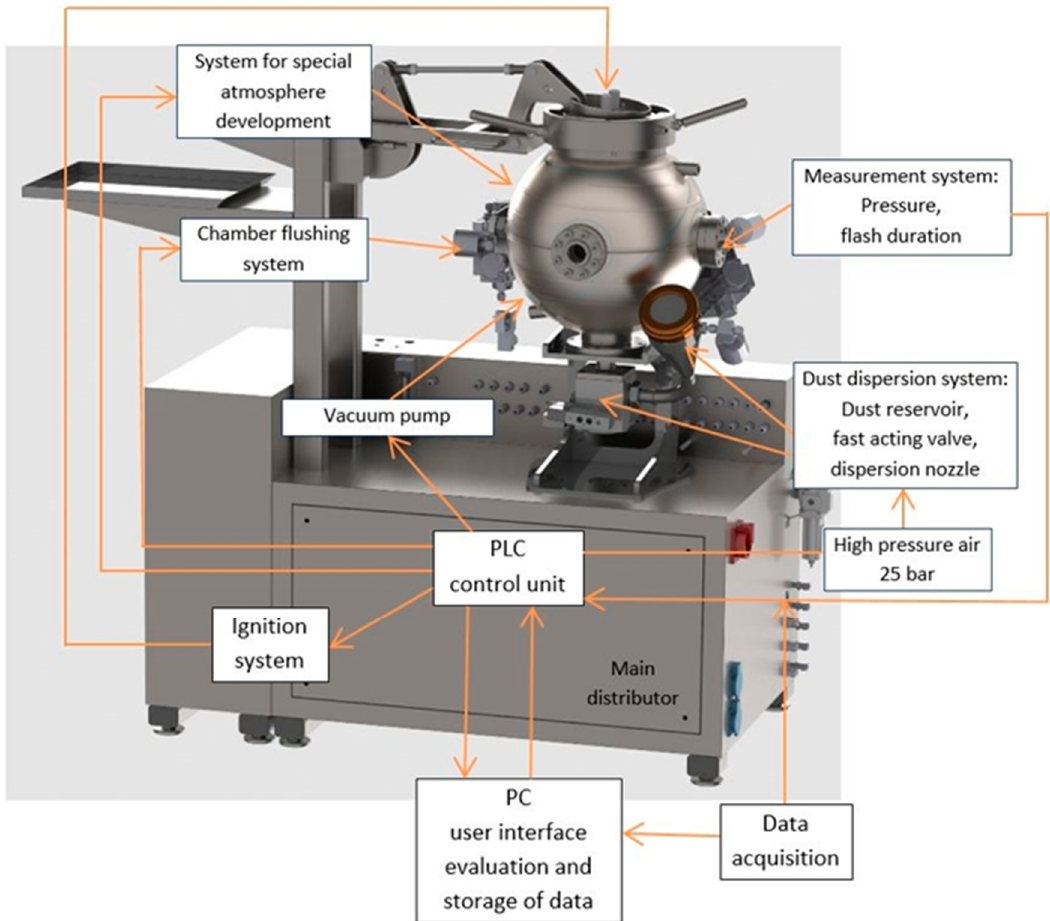
Figure 1. Experimental setup of the 0.02 m 3 spherical vessel.